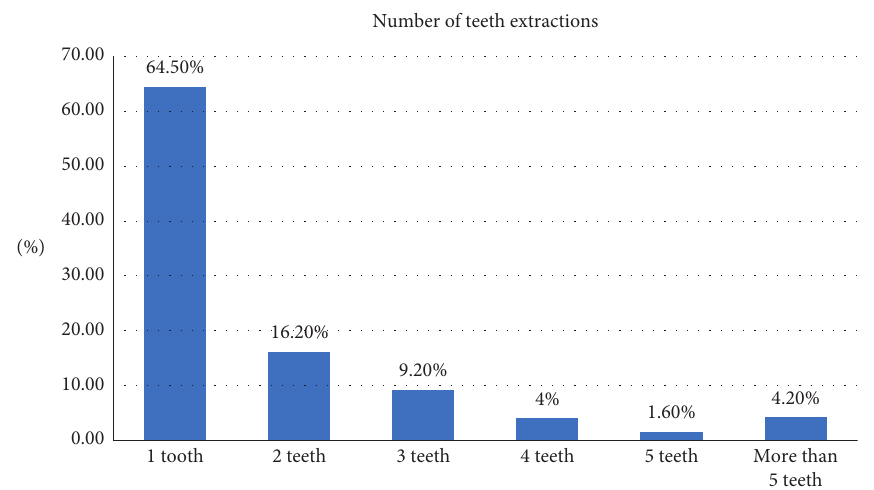
Figure 3: Distribution of the number of teeth extractions in